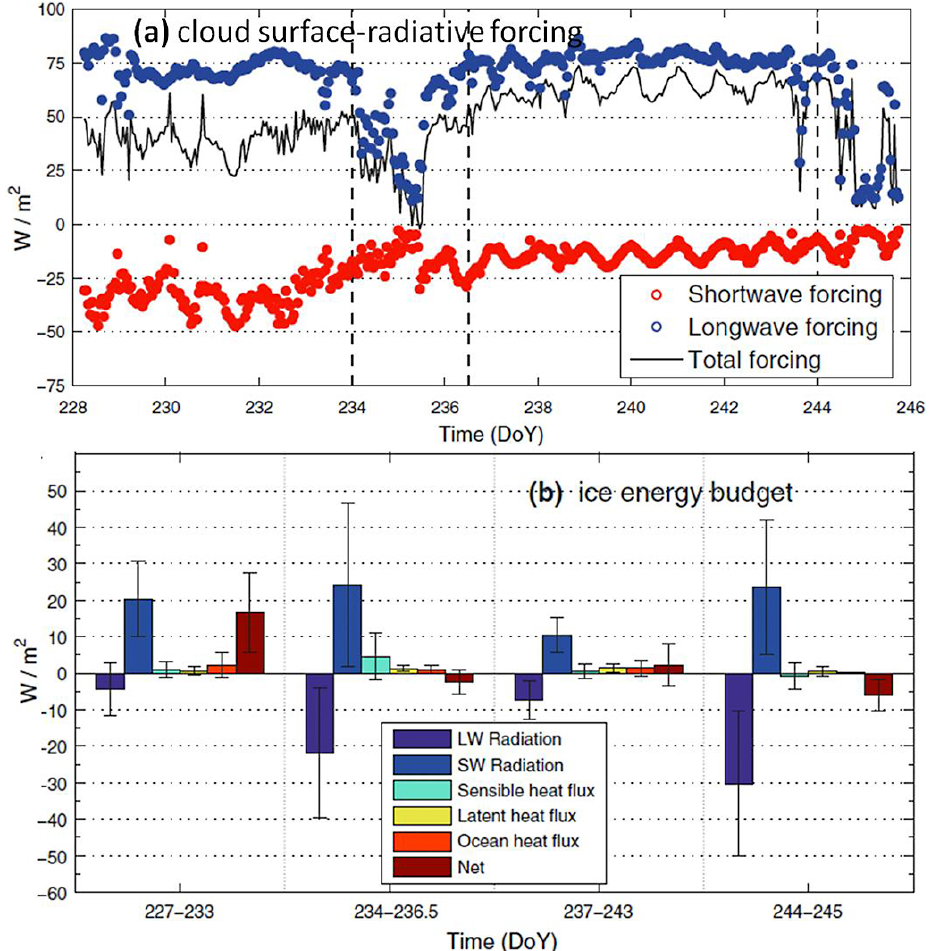
Fig. 16. (a) shortwave (red circles), longwave (blue circles) and total cloud radiative forcing (black line), all in Wm − 2 , and in (b) the mean components of the energy budget terms for the sea ice in Wm − 2 calculated over the four main time regimes identified by dashed black line in (a) . Positive fluxes represents a warming at the surface and negative flux a cooling, except for sensible and latent heat fluxes, which are defined traditionally where positive is cooling. The ice budget includes ocean heat flux and transmission of solar radiation but excludes conduction. Black variability bars represent ± 1 standard deviation of the mean fluxes for each respective regime, and the net flux is calculated as the residual. Figure is adapted from Sedlar et al.